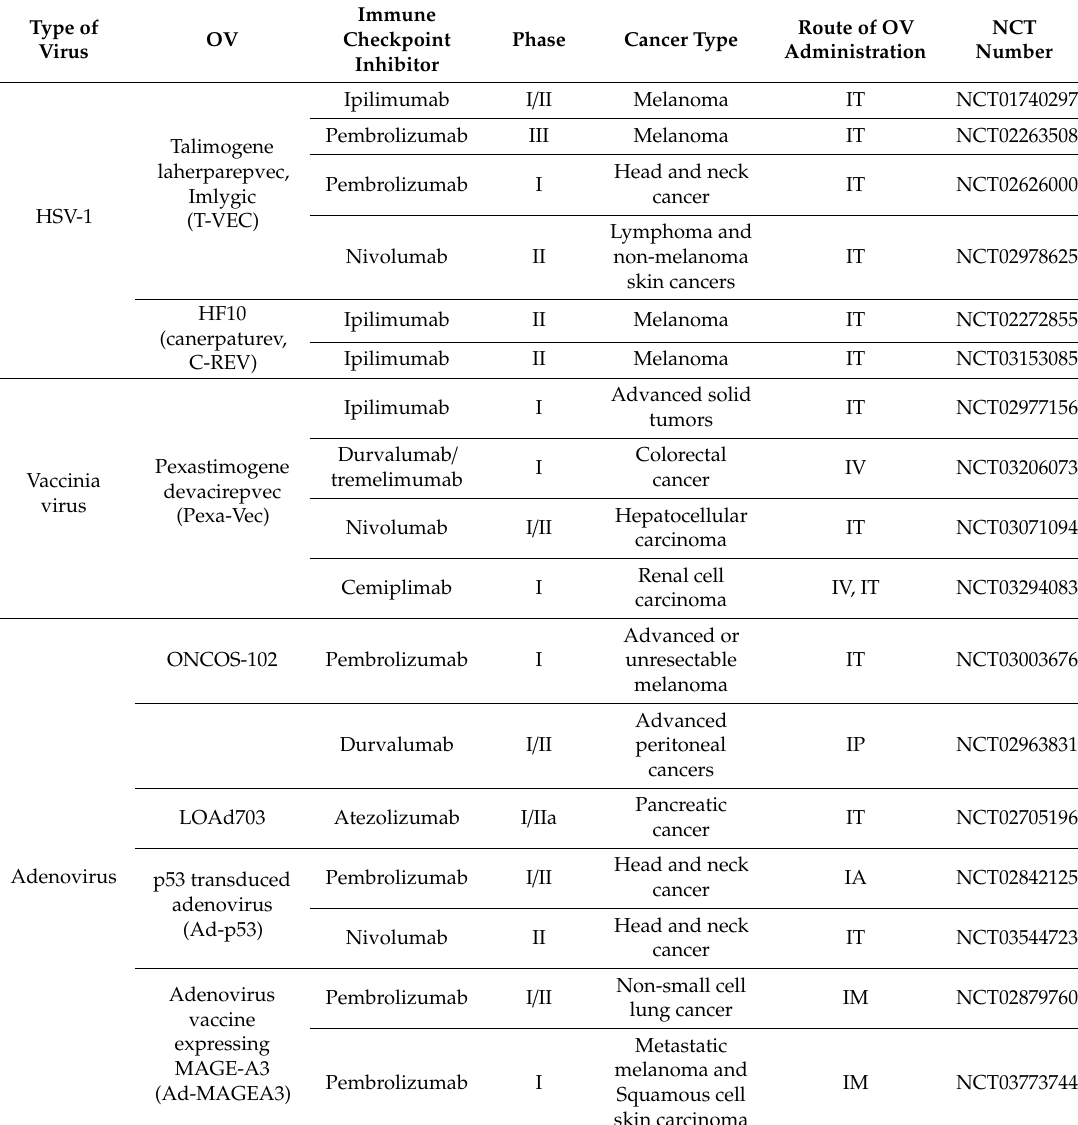
Table 2. Current clinical trials of combination therapy with OVs and immune checkpoint inhibitors (modified from Tao et al.